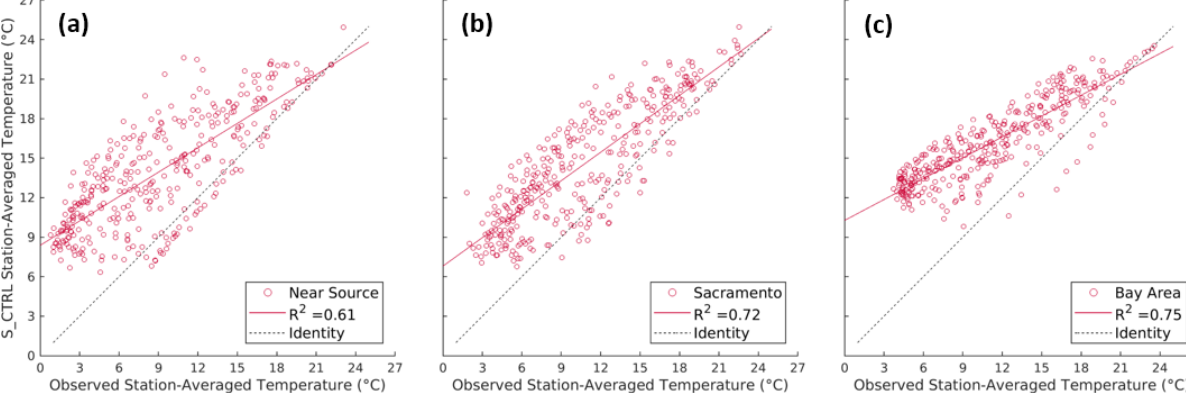
Figure 5. Comparison of AQS and NCDC temperature observations versus S_CTRL predictions: (a) near the wildfire ( N = 10), (b) Sacra- mento ( N = 7), and (c) the Bay Area ( N = 13). The solid red lines show a linear regression fit, while the dotted black lines denote 1 : 1 simulations versus observations. The simulations achieved a correlation coefficient R 2 of 0.61 near the fire, 0.72 in Sacramento, and 0.75 in the Bay